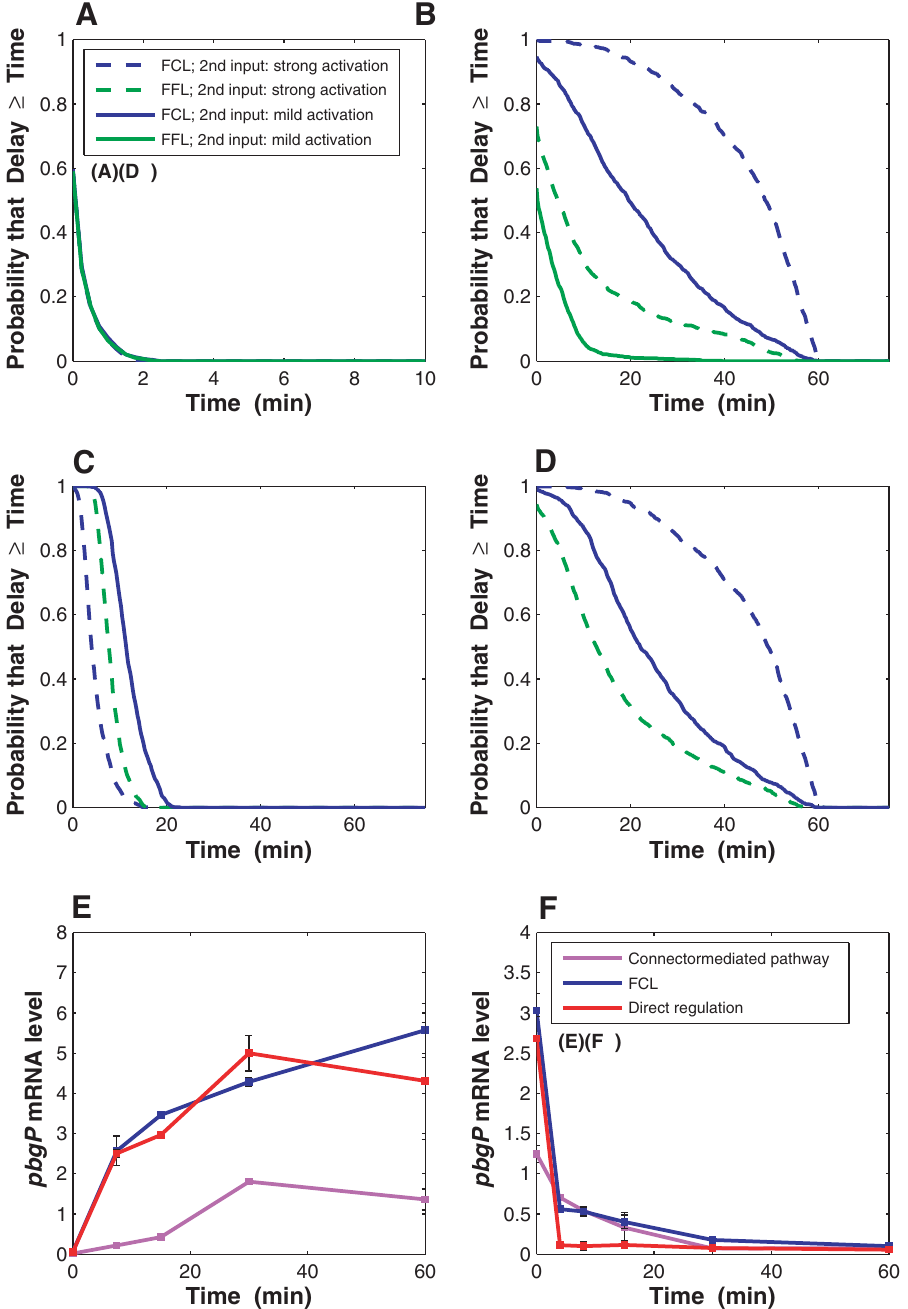
Figure 5. Activation and deactivation dynamics of connector-mediated and direct regulatory circuits. Delay length distributions for the feedforward connector loop (FCL) and feedforward loop (FFL) ((A)–(D)) and experimental measurements of activation and deactivation dynamics for the connector-mediated pathway, FCL, and direct regulation circuit ((E)–(F)). In the simulations, the second input with strong and mild activation corresponds to high and low ratios of phosphorylation/dephosphorylation rates for PmrA (or for protein Y of the FFL), respectively. In the activation and deactivation experiments, the connector-mediated pathway was harbored by the wild-type S. enterica strain (14028s) whereas the FCL and direct regulation circuit were harbored by the engineered S. enterica strains EG17353 and EG17354, respectively. mRNA levels were determined as described in Materials and Methods. (A) Activation delay length distributions for the FCL and FFL. (B) Deactivation delay length distributions for the FCL and FFL. (C) Activation delay length distributions for the FCL and FFL lacking direct activation branches. (D) Deactivation delay length distributions for the FCL and FFL lacking direct activation branches. (E) Activation dynamics for pbgP gene expression in S. enterica . (F) Deactivation dynamics for pbgP gene expression in S. enterica